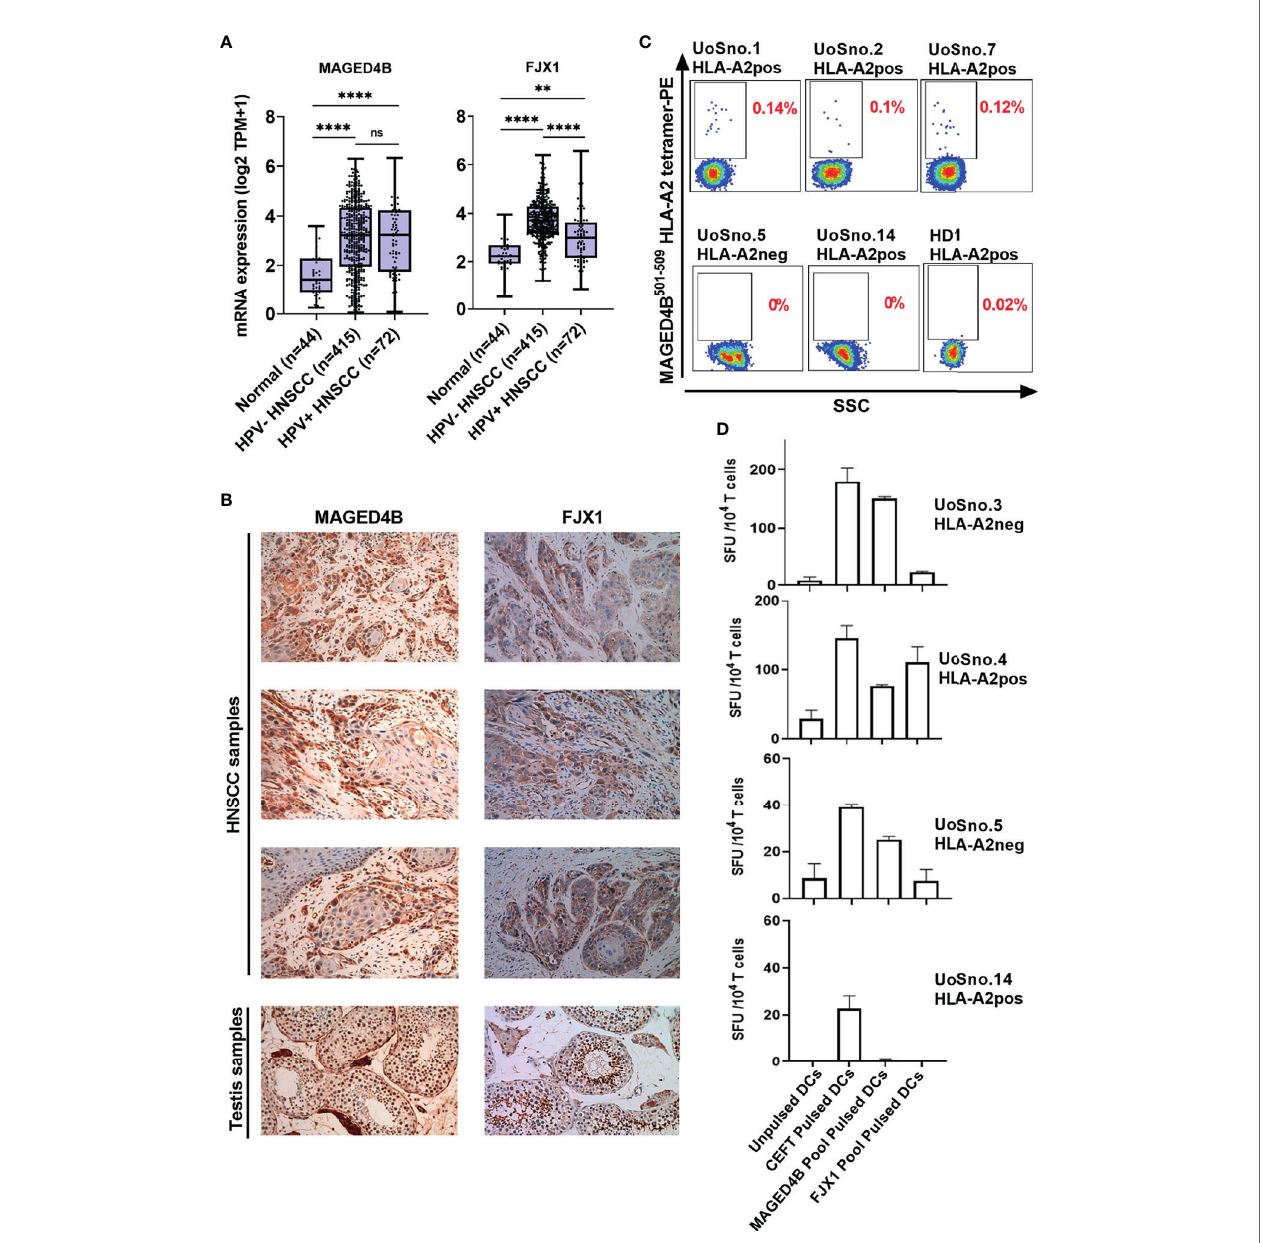
FIGURE 1 | MAGED4B and FJX1 are immunogenic tumour-associated antigens in HPV neg HNSCC patients. (A) Both HPV neg and HPV pos HNSCC samples from TCGA has signi fi cant elevation of MAGED4B and FJX1 compared to adjacent normal tissue at transcriptomic level. P values were calculated using Kruskal-Wallis test on normalized mRNA expression (**** p -value < 0.0001; ** p -value < 0.01; ns, not signi fi cant). (B) MAGED4B and FJX1 expression in HNSCC samples and testes (as positive control) were indicated by IHC staining with anti-hMAGED4B polyclonal antibody (Novus-Bio) and anti-FJX1 polyclonal antibody (Novus-Bio) respectively. Magni fi cation x200. (C) FACS plots showed MAGED4B -speci fi c T cells were detected in PBMC from HNSCC patients using MAGED4B 501-509 HLA-A2 tetramer-PE. Four HLA-A2 pos , one HLA-A2 neg HNSCC patients and one healthy donor are shown. (D) T cells from HNSCC patients after IVS were assessed with IFN g ELISpot. Antigen-speci fi c T cell responses were evaluated by stimulating with MAGED4B OPP and FJX1 OPP pulsed autologous DCs. CEFT OPP were used as positive control in IFN g ELISpot. Two HLA-A2 pos and two HLA-A2 neg HNSCC patients are